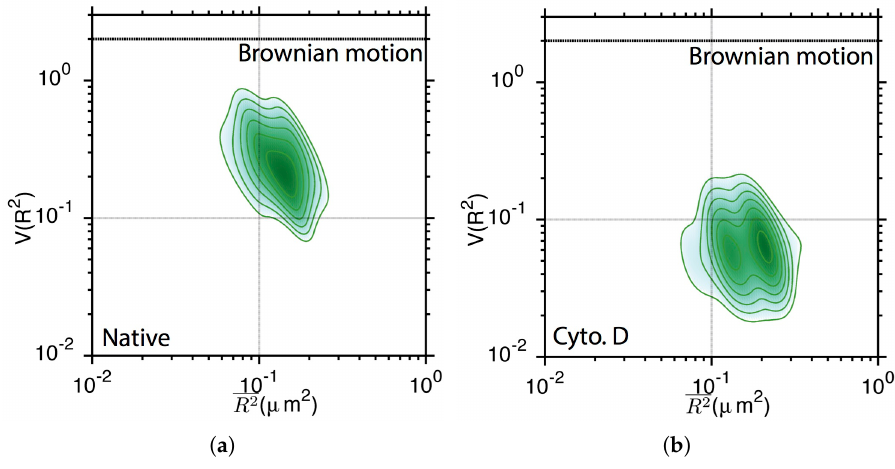
Figure 7. 2D contour plot of [ V ( R τ 2 )] - [ R τ ( t )] 2 histogram for TatP-QDs moving in the neighborhood of ( a ) living HeLa cell and ( b ) Cyto D-pretreated